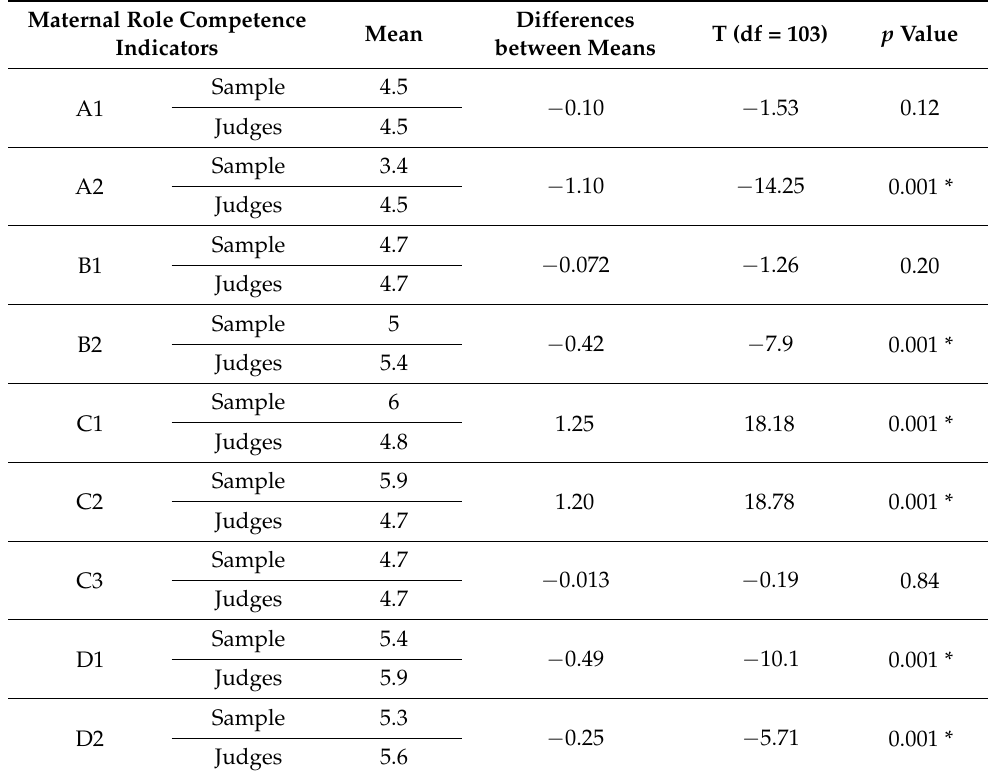
Table 3. Comparison between the Q-sort scores obtained by the sample and the maternal role competence criteria at T2 (paired sample t -test) ( n = 104).